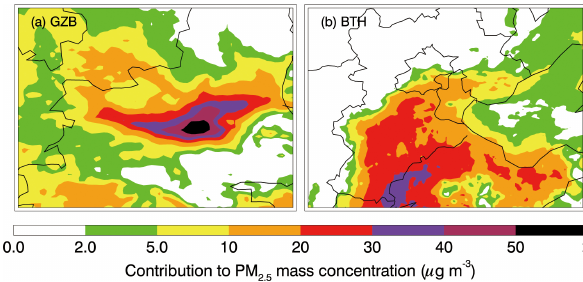
Figure 16. Distribution of the average near-surface PM 2 . 5 contri- bution due to the SO 2 heterogeneous reactions in GZB and BTH during the simulated